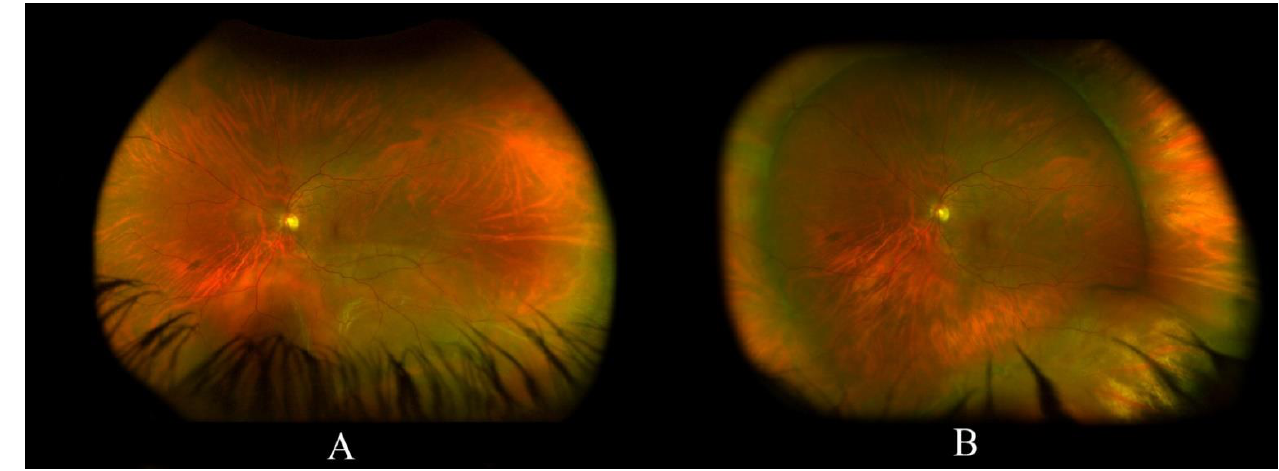
Figure 1. ( A ) a left eye inferior rhegmatogenous retinal detachment in a young phakic patient, the macula looks attached; ( B ) a fully reattached retina following scleral buckling with a 360 encircling band with an inferotemporal buckle.